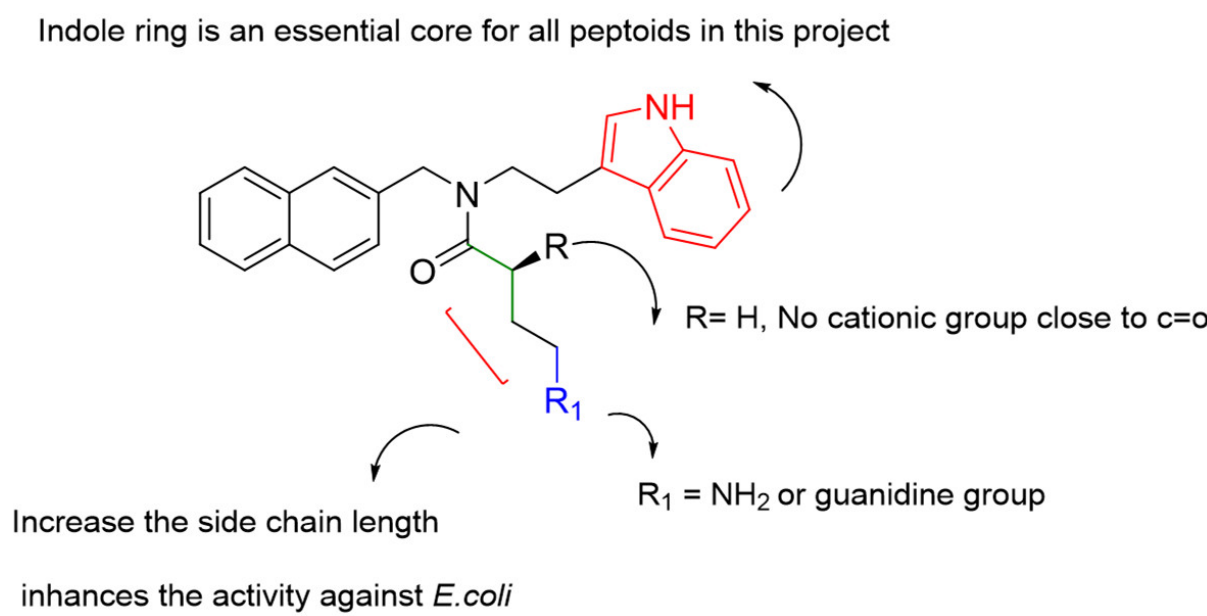
Figure 7. SAR of the most active compounds against E. coli K12.